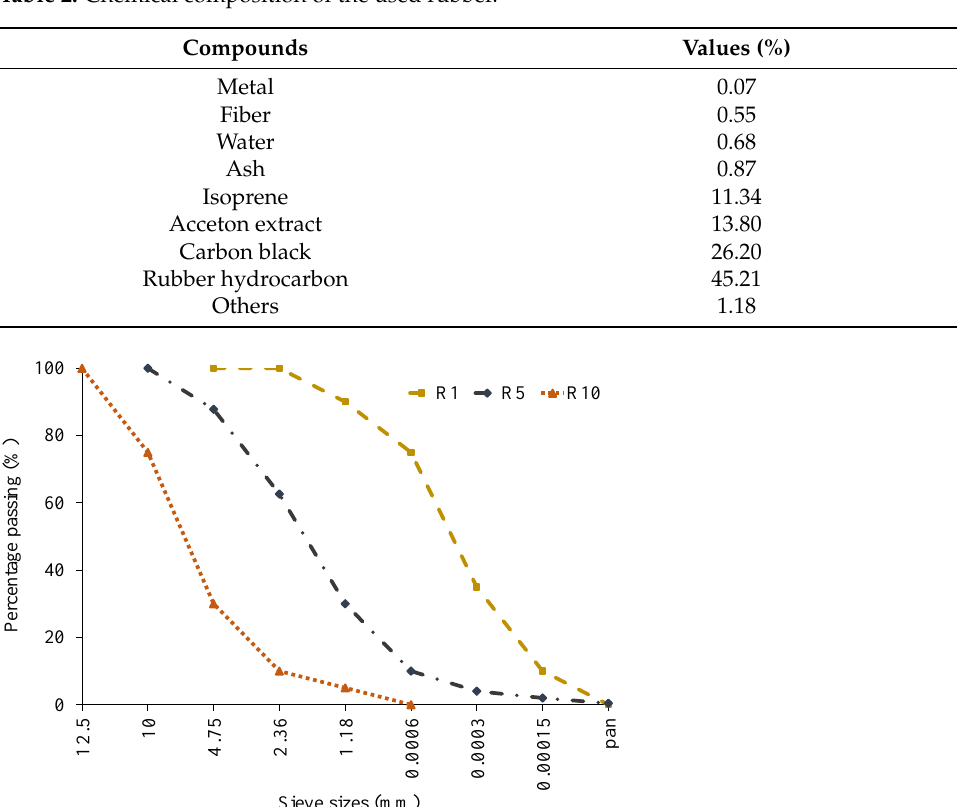
Table 2. Chemical composition of the used rubber.